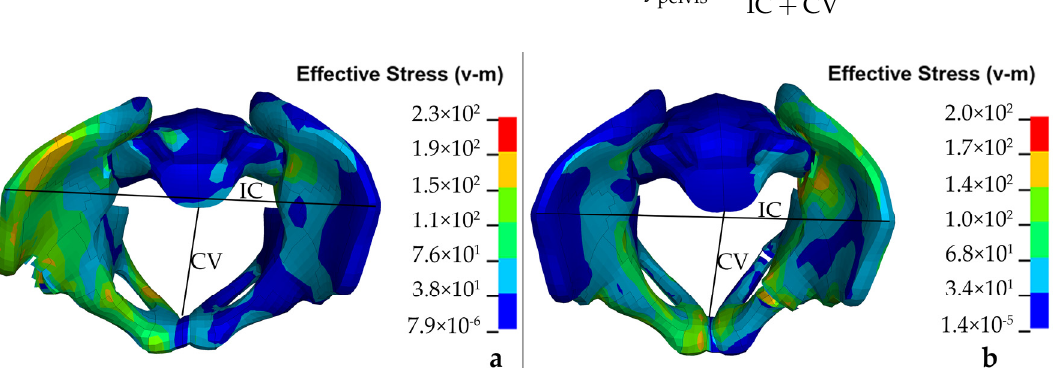
Figure 10. Pelvic deformation patterns under different normalized eccentricities. ( a ) 90° run-over at 40 km/h with a normalized eccentricity of 1.44; ( b ) 0° impact at 50 km/h with a normalized eccentricity of 0.34.